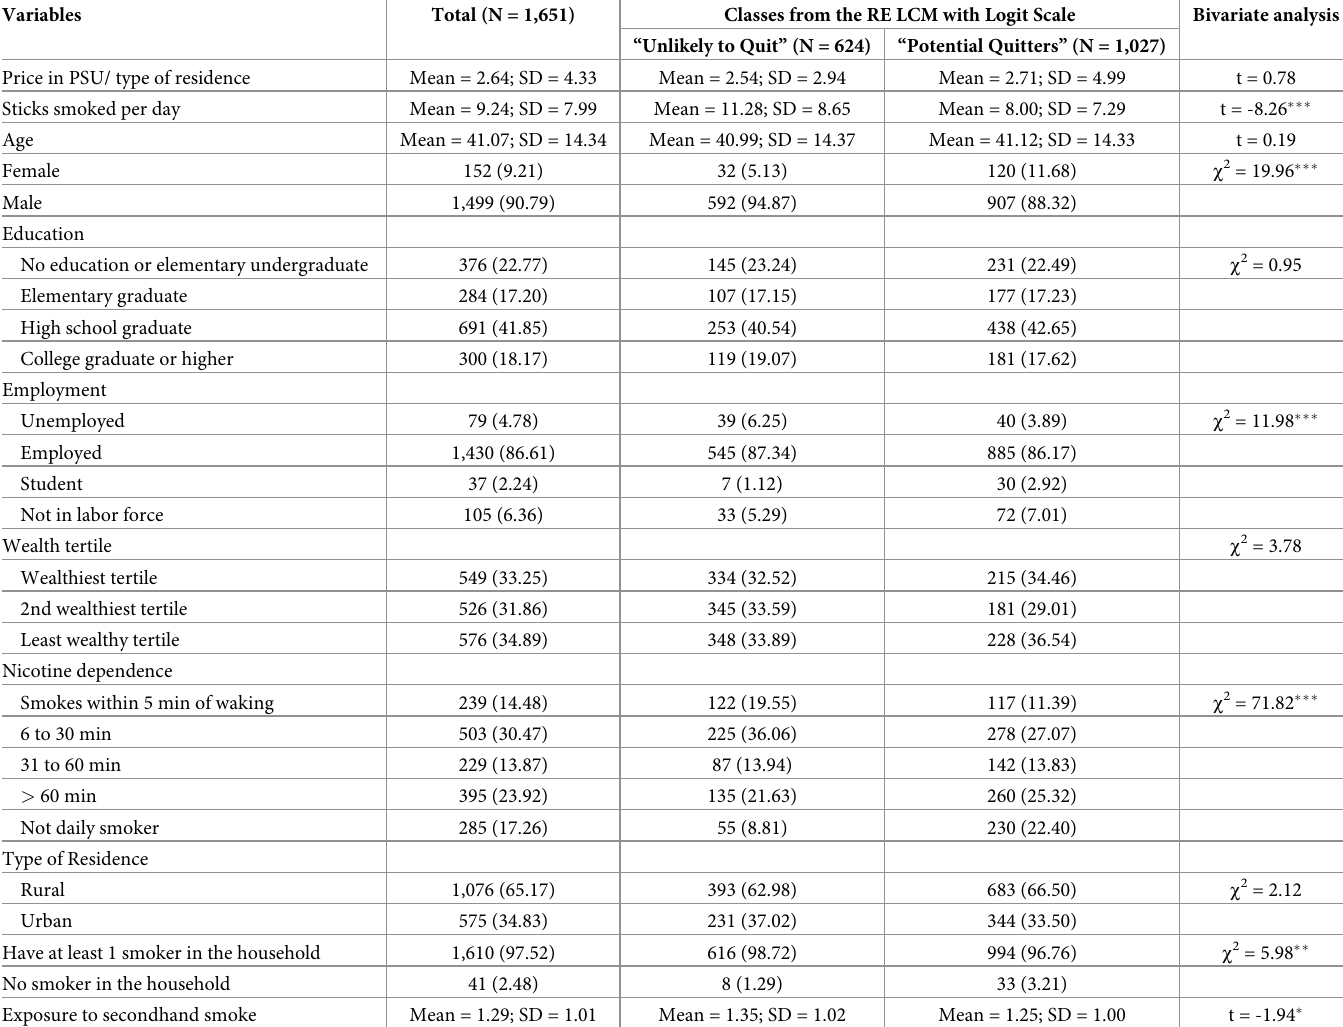
Table 2. Statistics by